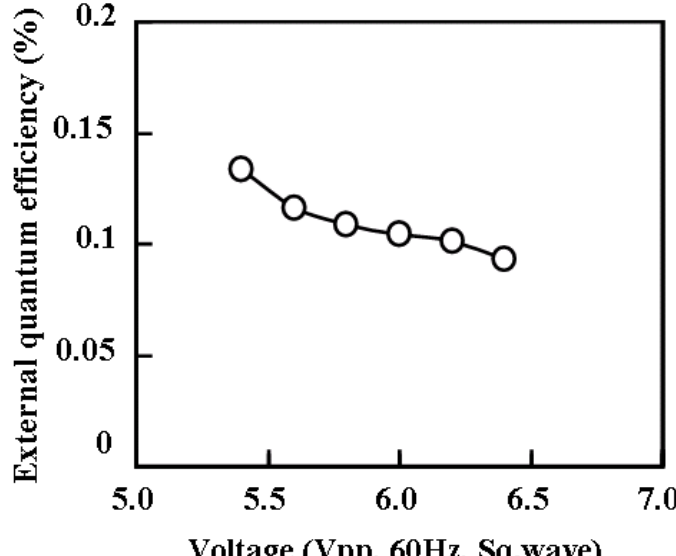
Figure 6. The external quantum efficiency of ECL gel with 45 wt % of TiO as a function of the applied voltage.